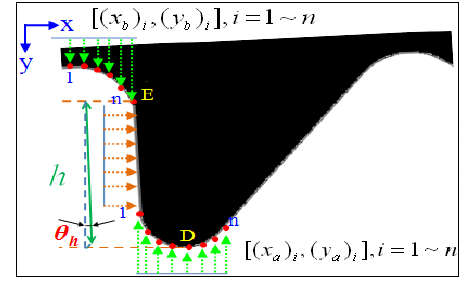
Figure 10. “Processing height h ”.